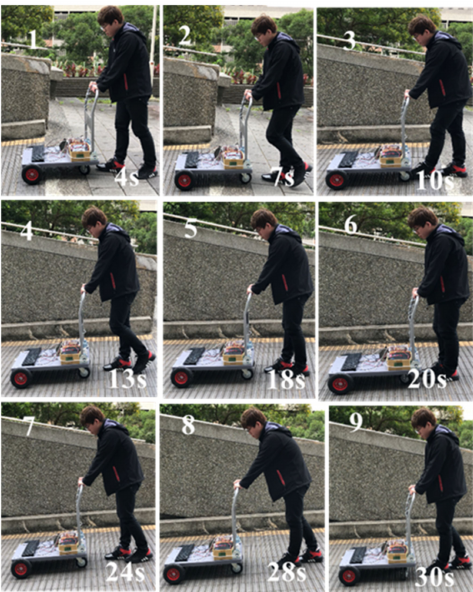
Figure 11. Snapshots of smart walker assisted in downhill.